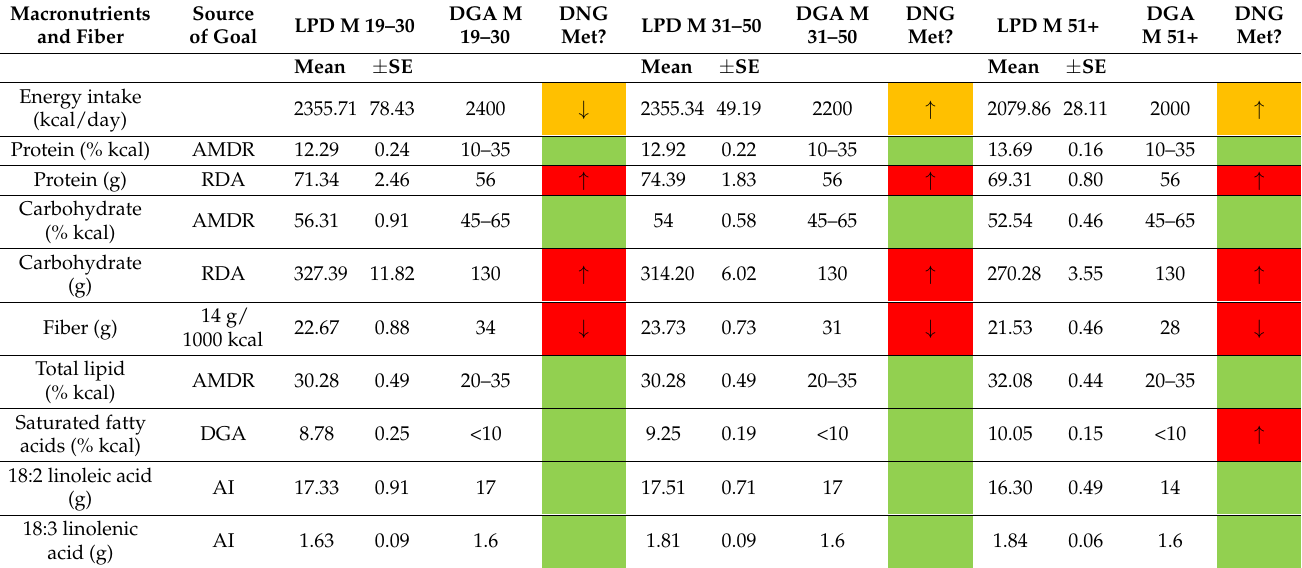
Table 2. Macronutrient and fiber intake in males following an LPD compared to the DNGs in the 2020–2025 DGA stratified by age group.